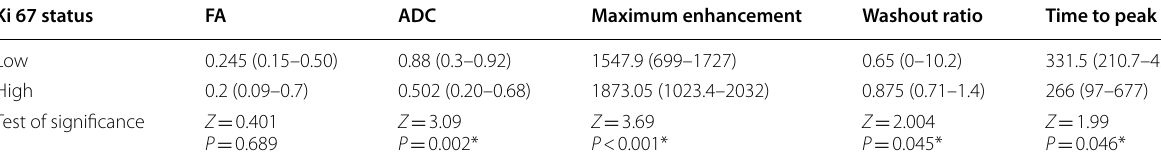
Table 2 FA, ADC, maximum enhancement, washout ratio & time to peak among low and high Ki67 cases